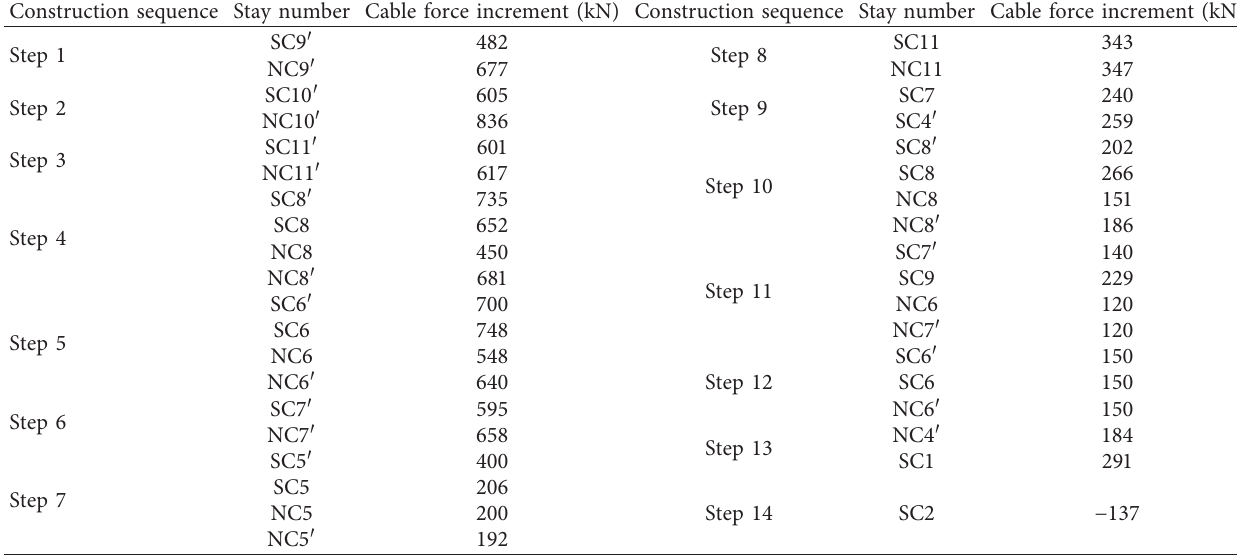
Table 2: Final cable adjustment scheme in Yonghe Bridge.